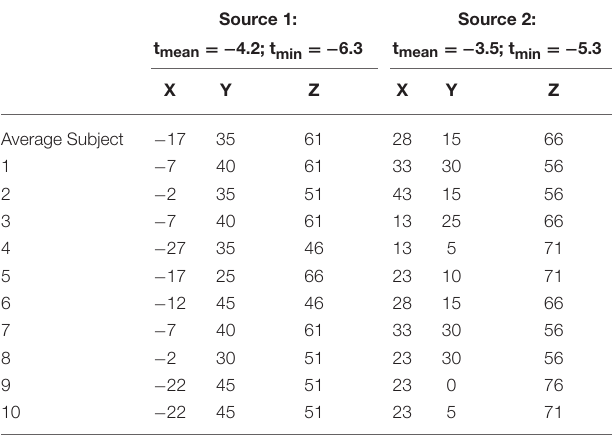
TABLE 2 | Mean and individual locations (CTF coordinates) of sources for the contrast walking vs. sitting.